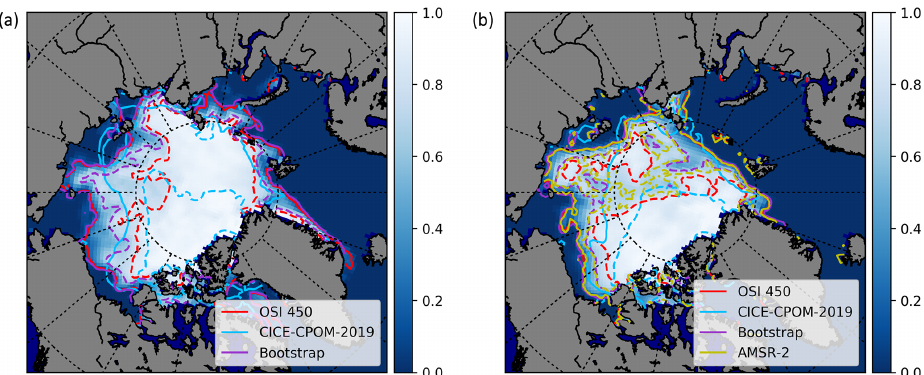
Figure 5. The location of the MIZ for August 1993 (a) and August 2013 (b) . The MIZ has been trending northwards in recent years (see also Fig. 3 for a time series of latitudes). Dashed and solid lines represent the 80% and 15% sea ice concentration levels, respectively. AMSR data are not available prior to 2002. Underlying sea ice concentration is taken from the OSI-450 satellite